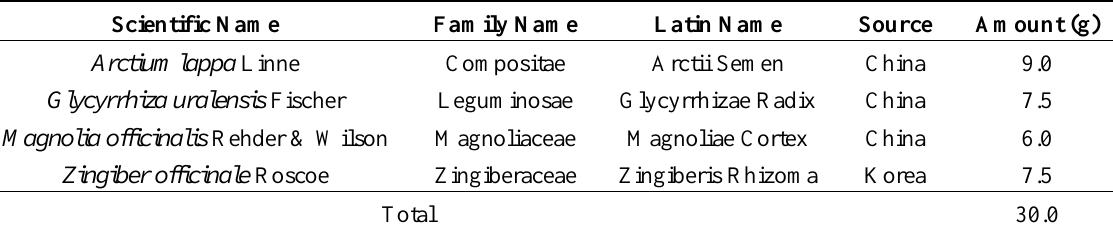
Table 1. Medicinal herbs included in